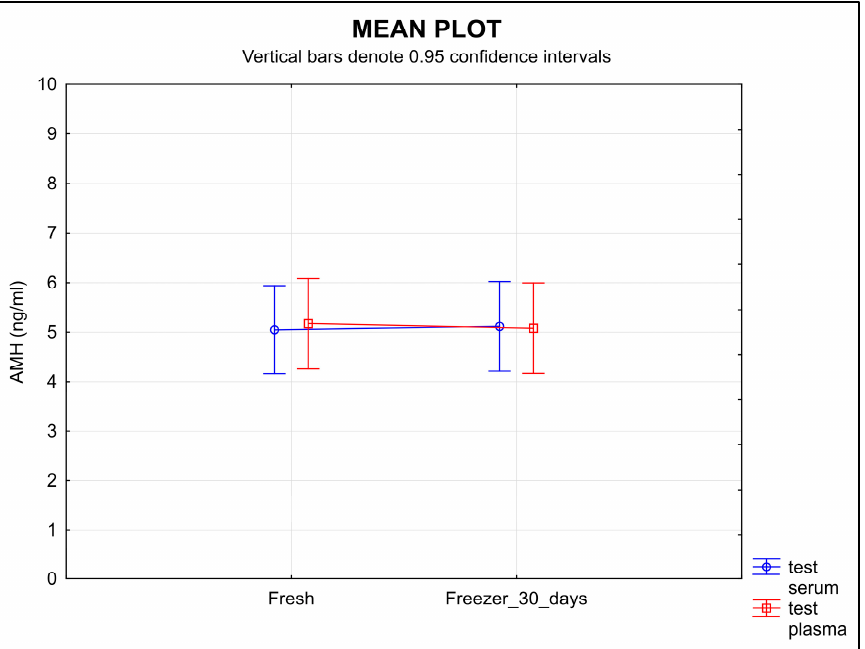
Figure 5. The stability of AMH during the 30 ‐ day storage at − 20 °C. The molecule showed high stability in both serum and plasma samples. Legend: The stability of AMH in the samples stored for 30 days at − 20 °C did not show any significant change in concentration over time in either type of sample. Equivalence was proved at a ±0.30 ng/mL limit of tolerance ( p < 0.0001 for serum, p = 0.0238 for plasma).